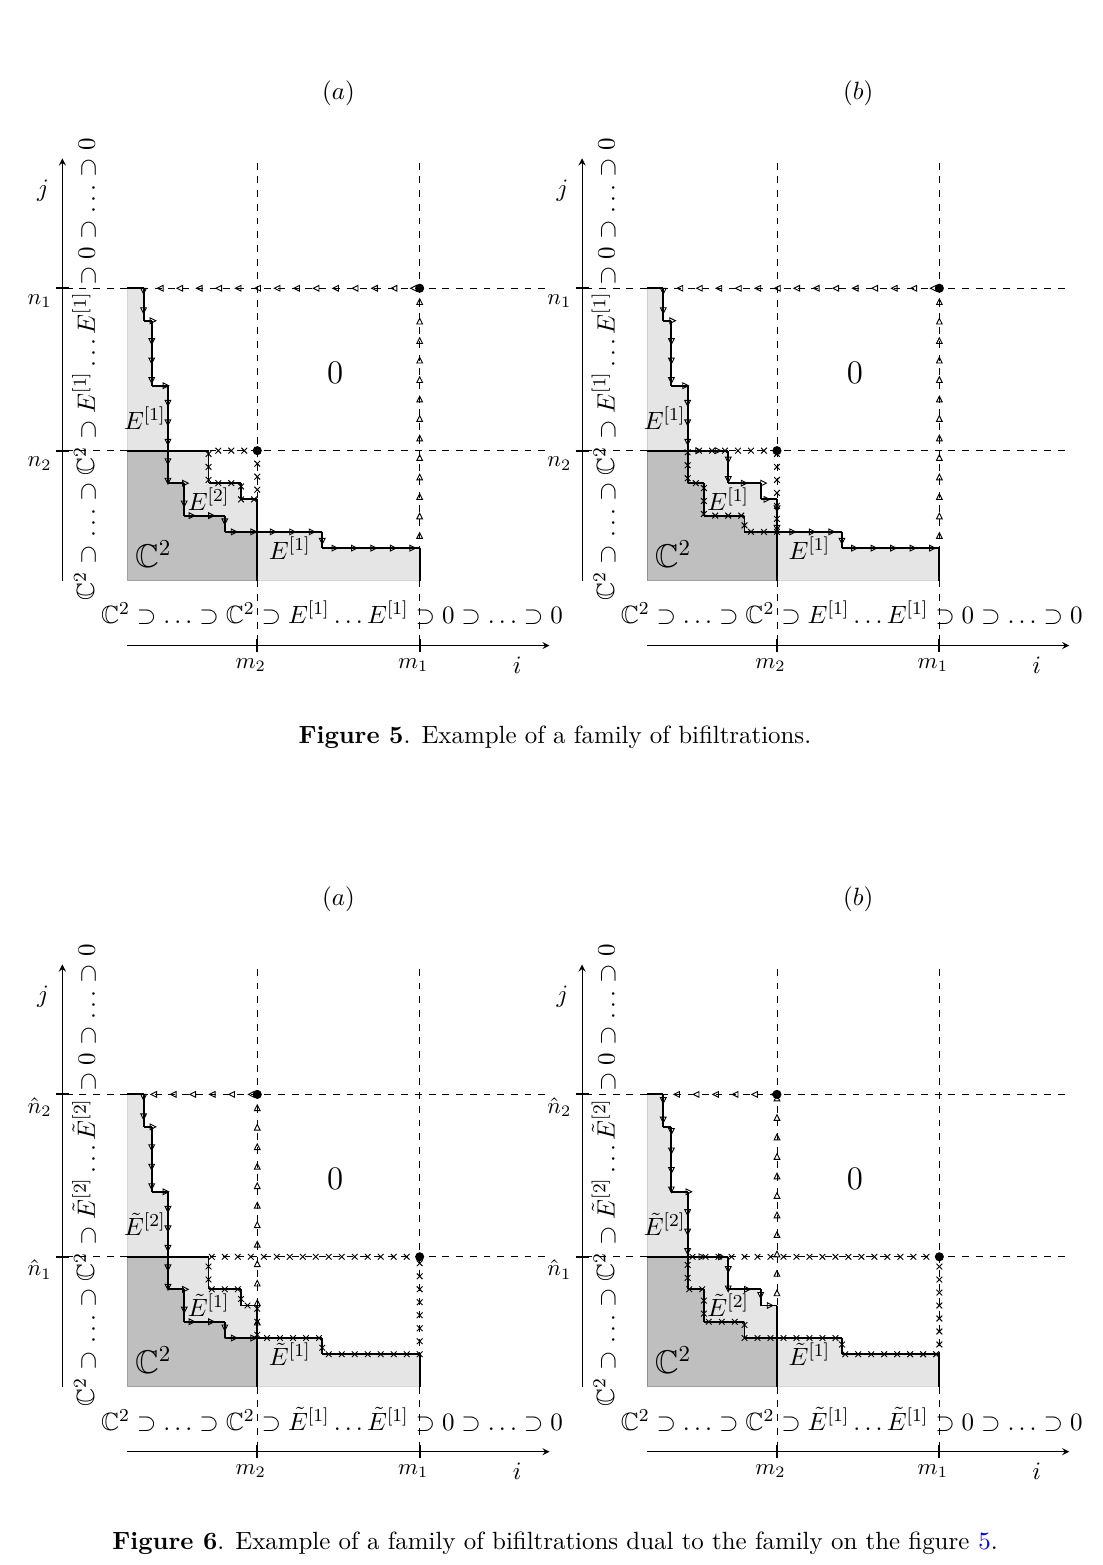
Figure 6 . Example of a family of bifiltrations dual to the family on the figure